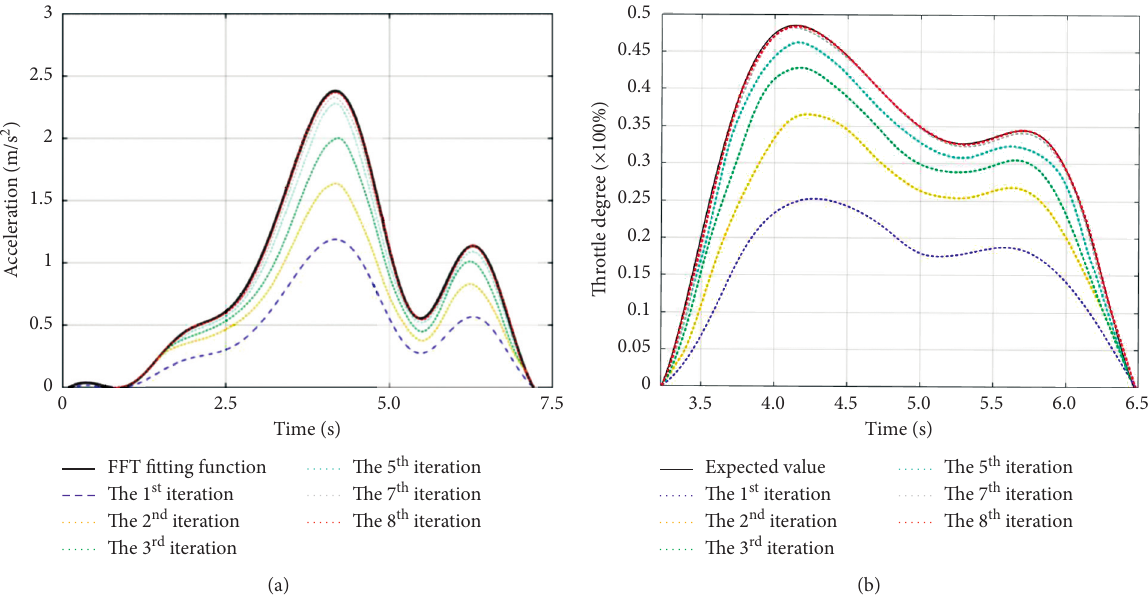
Figure 7: The results of the vehicle automatically start based on the IL control method. (a) Acceleration following with multiple iterations. (b) Throttle change with acceleration